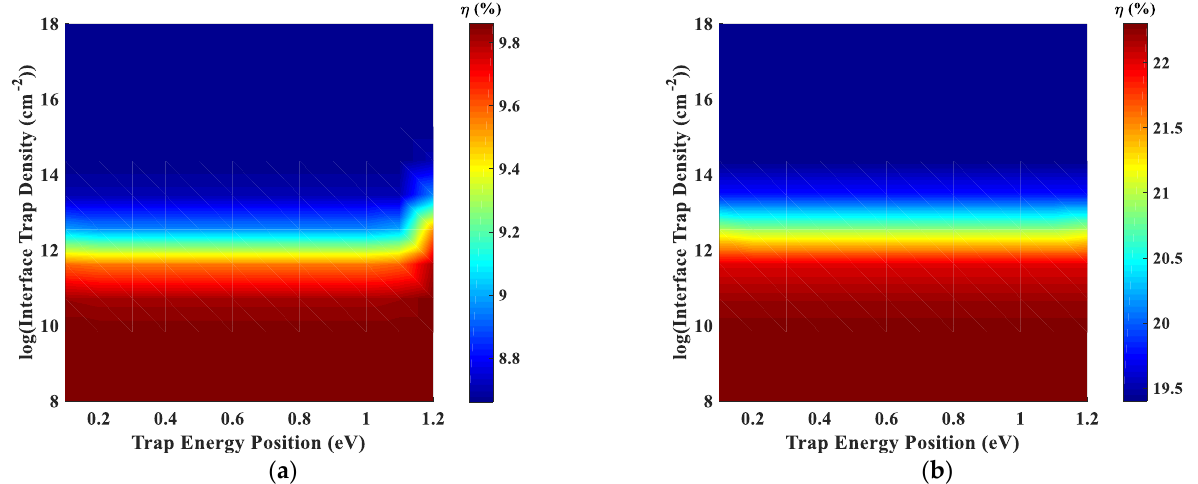
Figure 20. Effect of interfacial trap parameters on the efficiency of ( a ) initial hetero/homojunction solar cell and ( b ) final optimized HTL-free structure. Table 5. Comparison between five different cases of hybrid hetero-homojunction-based PSCs.